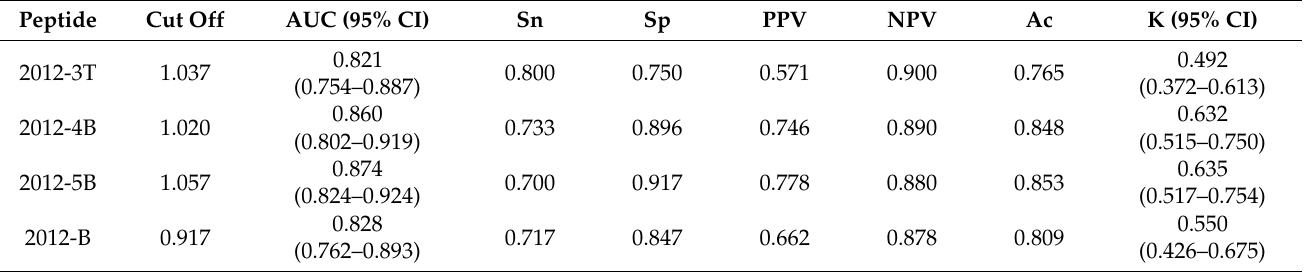
Table 4. The performance of peptide-based ELISA evaluated with LipL32 antigen